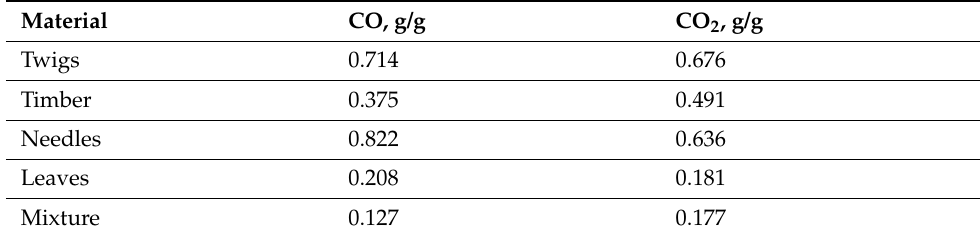
Table 5. Yields of pyrolysis and combustion products from forest